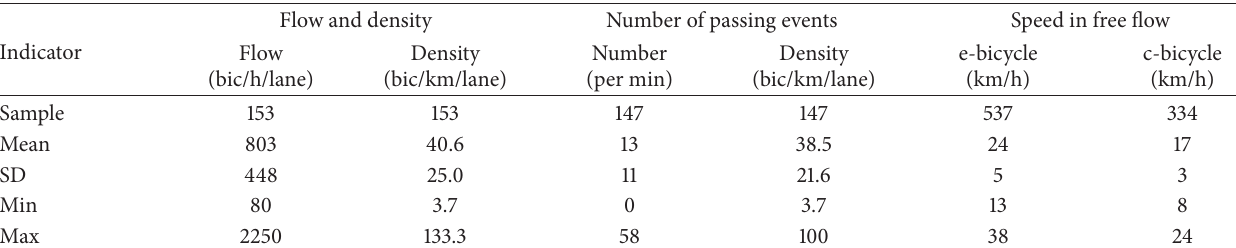
Table 1: Summary statistics of bicycle traffic